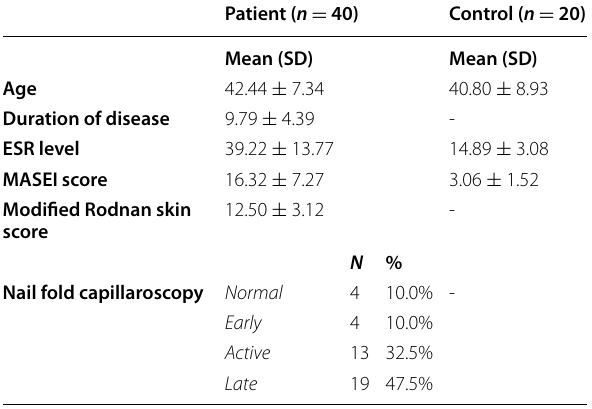
Table 1 Demographic and clinical data of systemic sclerosis patients and controls